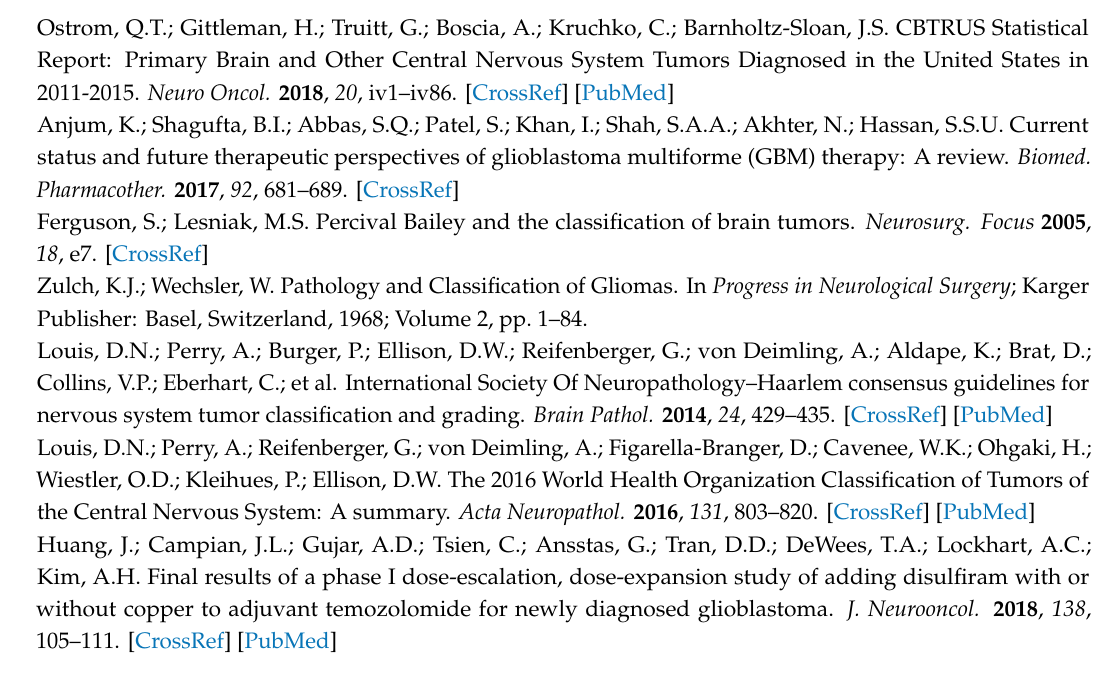
Table S1: Ongoing clinical trials of targeted therapeutic agents summarized from www.clinicaltrials.gov. The details are collected from corresponding clinical trials and www.cancer.gov. The superscript numbers are unique for the therapeutic agents listed in Table S1 and are used to identify an agent in case of repeated presence in the table. They are unrelated to the superscript numbering used in Table